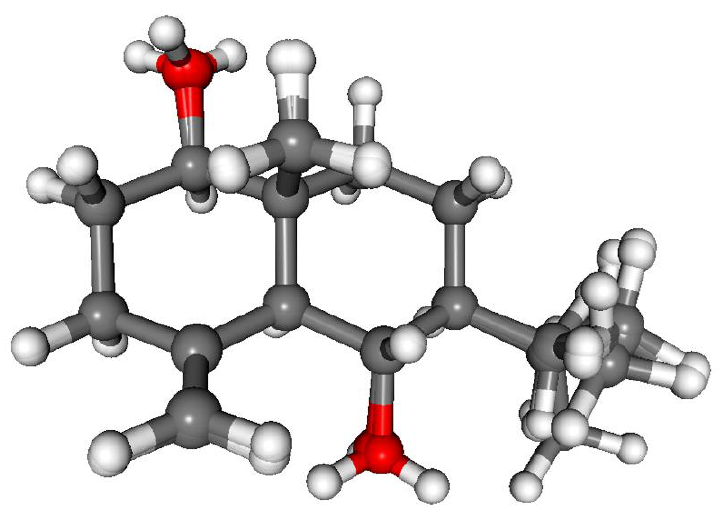
Figure 14. Overlapped geometries of the twelve low-energy CAM-B3LYP/TZVP PCM/MeCN conformers of (1 R ,5 S ,6 S ,7 S ,10 R )- 9 .